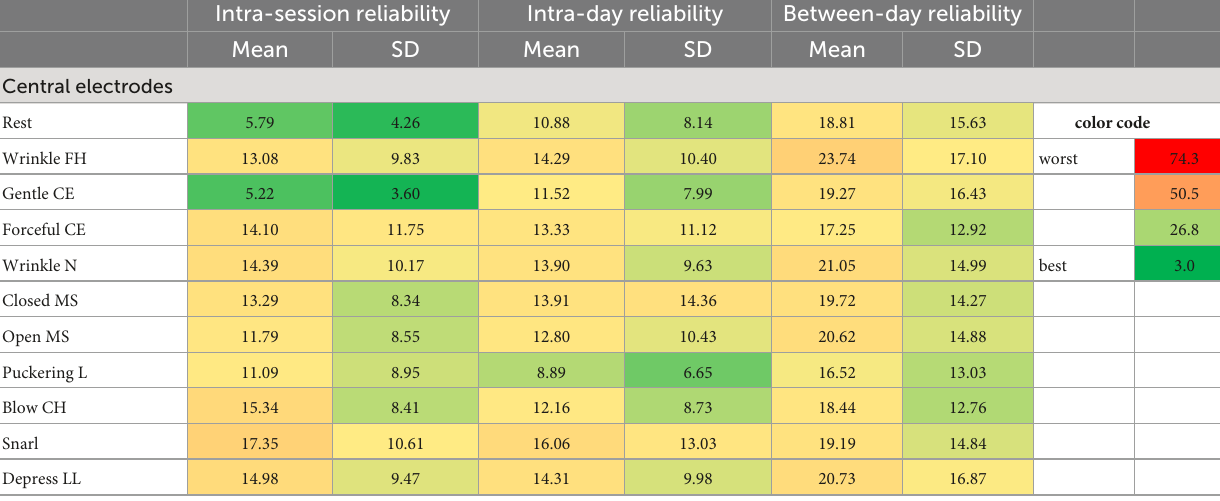
TABLE 4B Coefficient of variation statistics: Test and re-test reliability of the surface EMG recordings during the facial movement tasks for the central